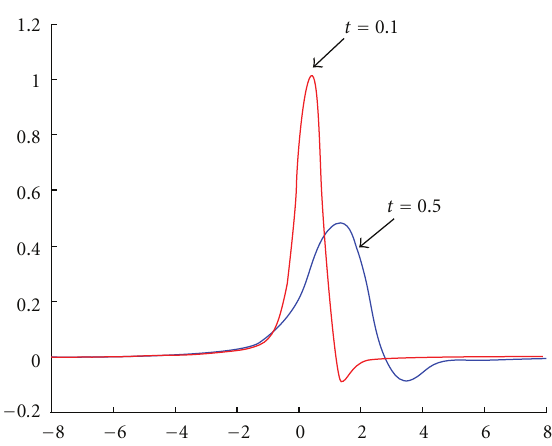
Figure 2: Evolution of the kernel K for t (cid:8) 0 . 1 (cid:5) red (cid:6) and t (cid:8) 0 . 5s (cid:5) blue (cid:6)